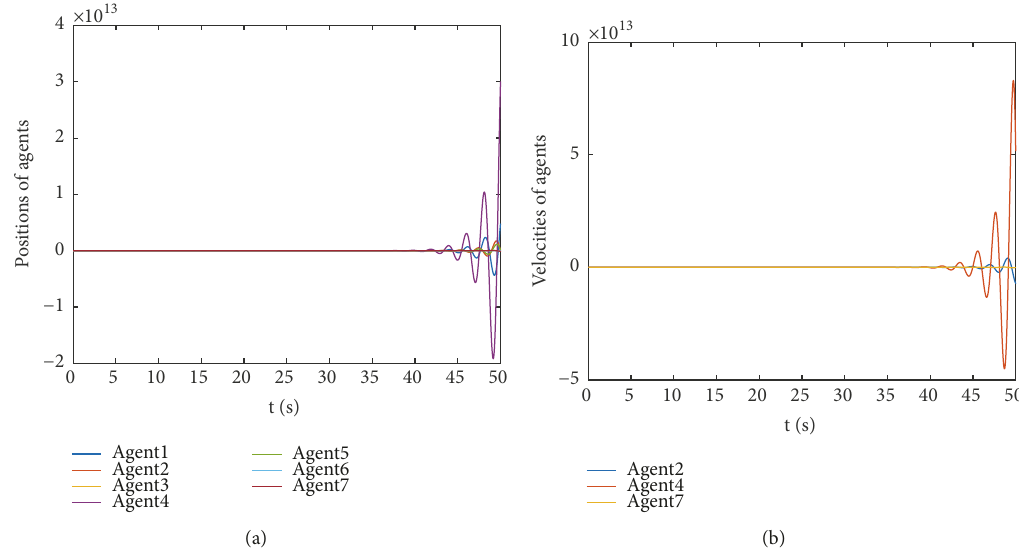
Figure 9: The state trajectories of the agents under directed topology in Figure 6 with different input time delays 𝜏 1 = 0.2 , 𝜏 2 = 0.1 , 𝜏 3 = 0.1 , 𝜏 = 0.5 , 𝜏 = 0.5 , 𝜏 = 0.5 , 𝜏 = 0.2 , communication delay 𝜏 4 5 6 7